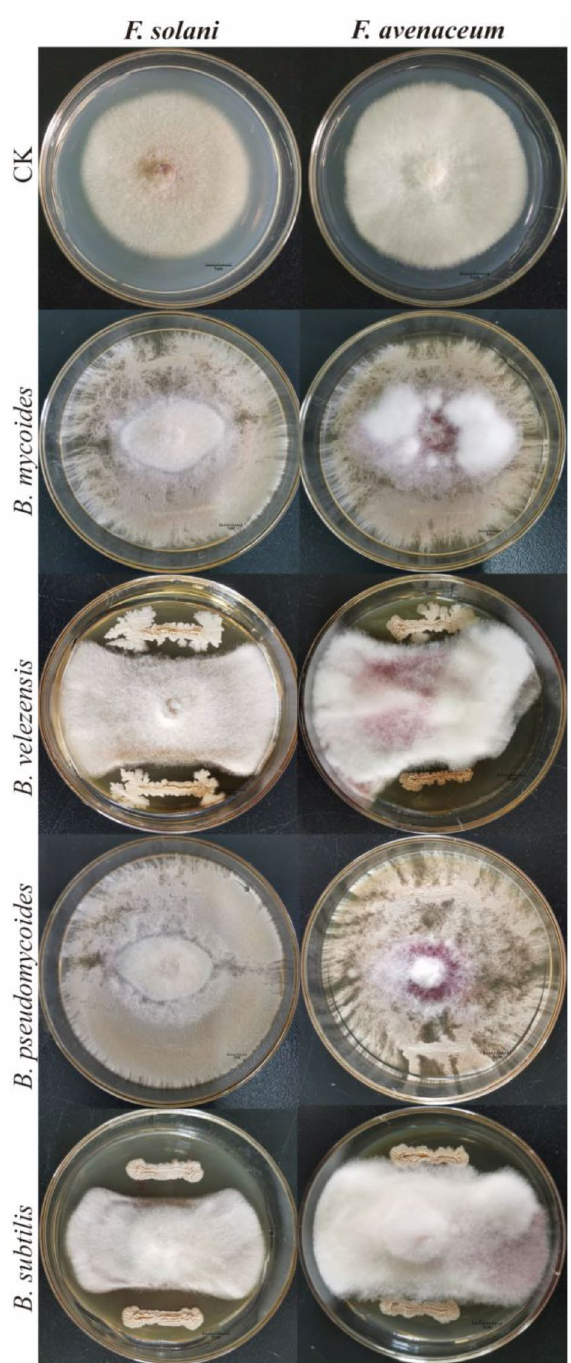
Figure 7. Bacteria with antagonistic activity against root rot pathogens of Cc by the dual culture method.CK: without the antagonistic